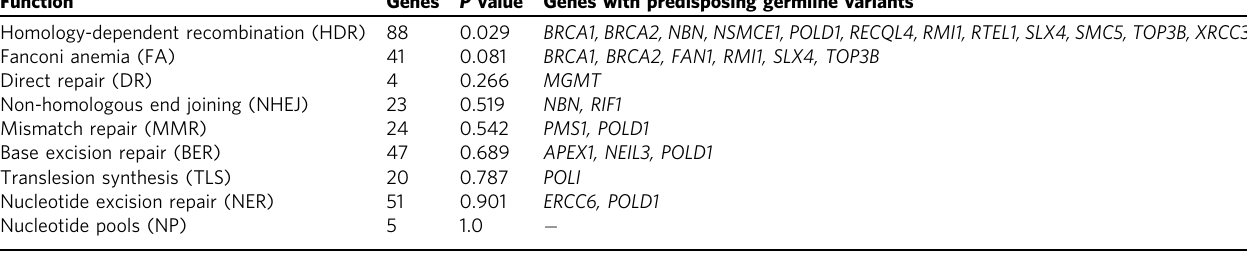
Table 1 Germline variants of CMT in DNA damage-repair